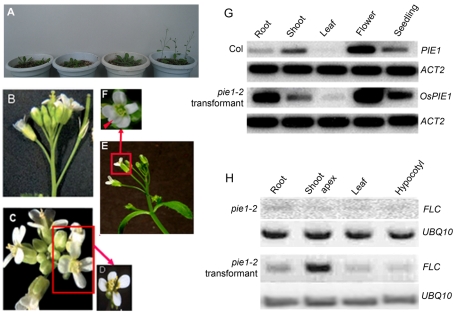
Rescue of the pie1-2 mutant phenotypes by transgenic expression of OsPIE1.(A) to (F) Phenotypes of transgenic Arabidopsis pie1-2 plants transformed with OsPIE1 under the control of the Arabidopsis PIE1 promoter. (A) Plants of two representative transformant (middle), WT (left) and the pie1-2 mutant (right) grown under long-day conditions (16 h light/8 h dark) until pie1-2 plants flowered. Inflorescence of transgenic pie1-2 plant (C) was compared with that of WT (B) and pie1-2 mutant (E). Abnormal floral organ number (with an extra petal indicated by arrowhead in F) in pie1-2 mutant was rescued in transformants of pie1-2 (with 4 petals; D). (G) RT-PCR analysis of PIE1 and OsPIE1 expression patterns. Expression of PIE1 was conducted in Col (wild-type), and OsPIE1 in pie1-2 transformants (Arabidopsis PIE1 promoter:OsPIE1 cDNA). Tissues or organs were collected from adult plants grown in long days. Arabidopsis ACT2 was used as an internal control. (H) Gel blot analysis of FLC expression in various tissues or organs from pie1-2 or one representative pie1-2 transformant (transformed with OsPIE1 under the control of Arabidopsis PIE1 promoter). The blots were probed first with FLC and then re-probed with Arabidopsis UBQ10 as an internal control.